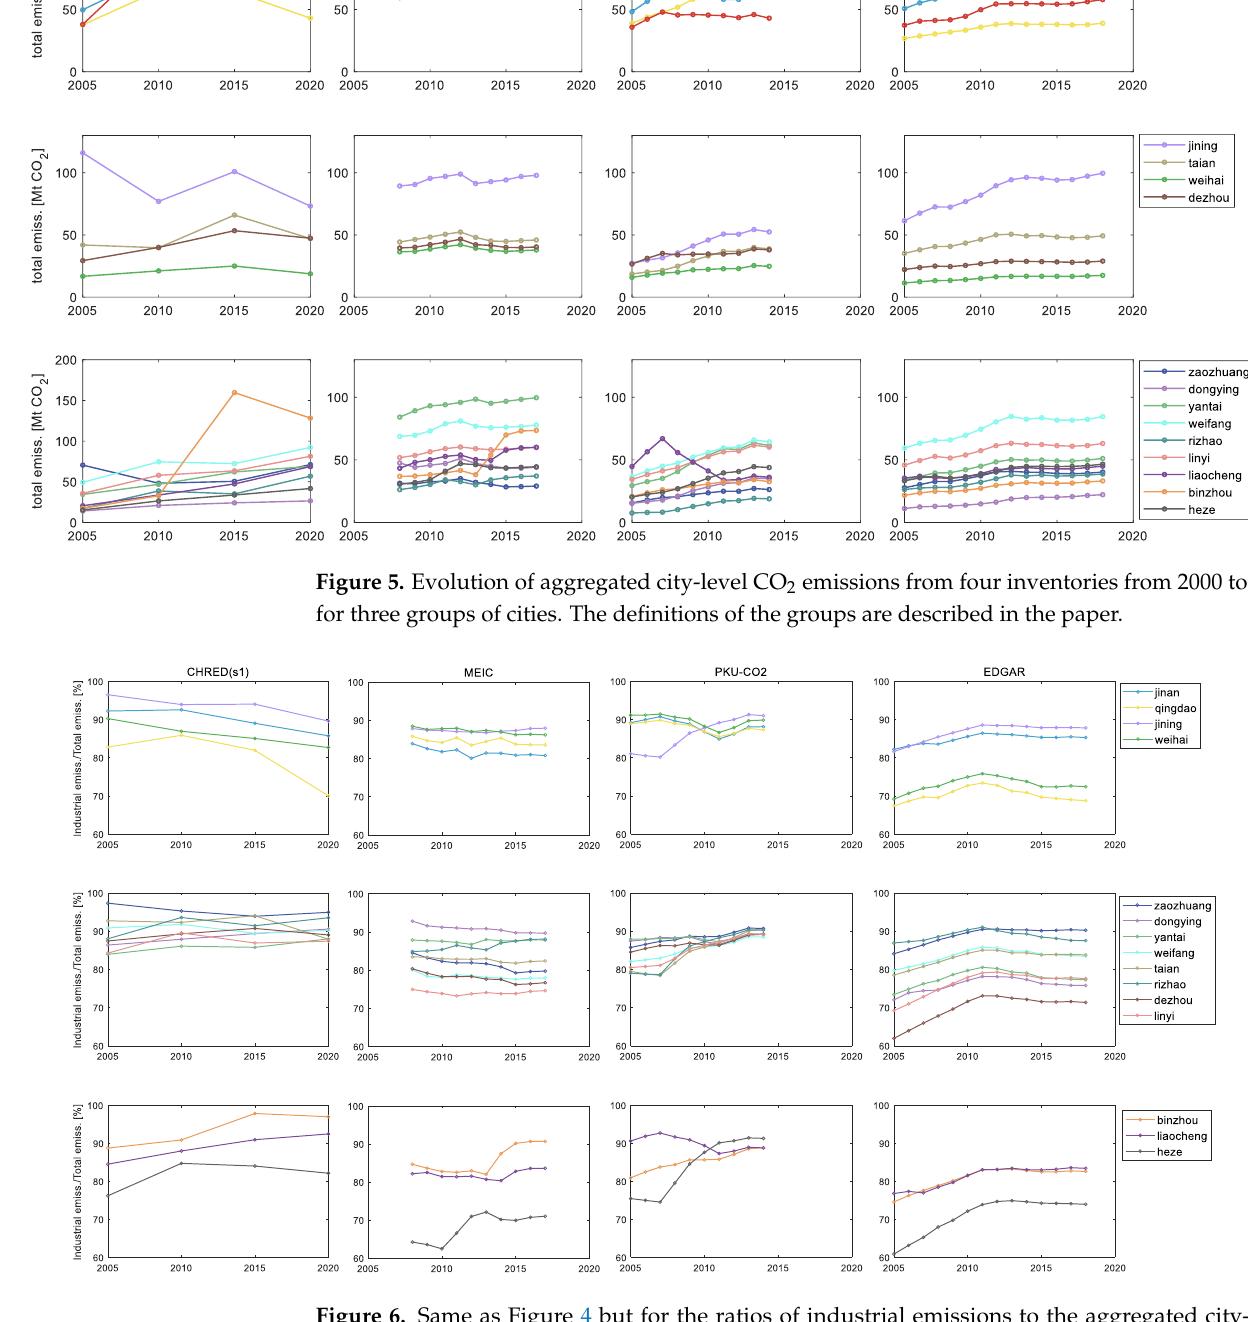
Figure 6. Same as Figure 4 but for the ratios of industrial emissions to the aggregated city-level emissions. The definitions of the groups are described in the paper.